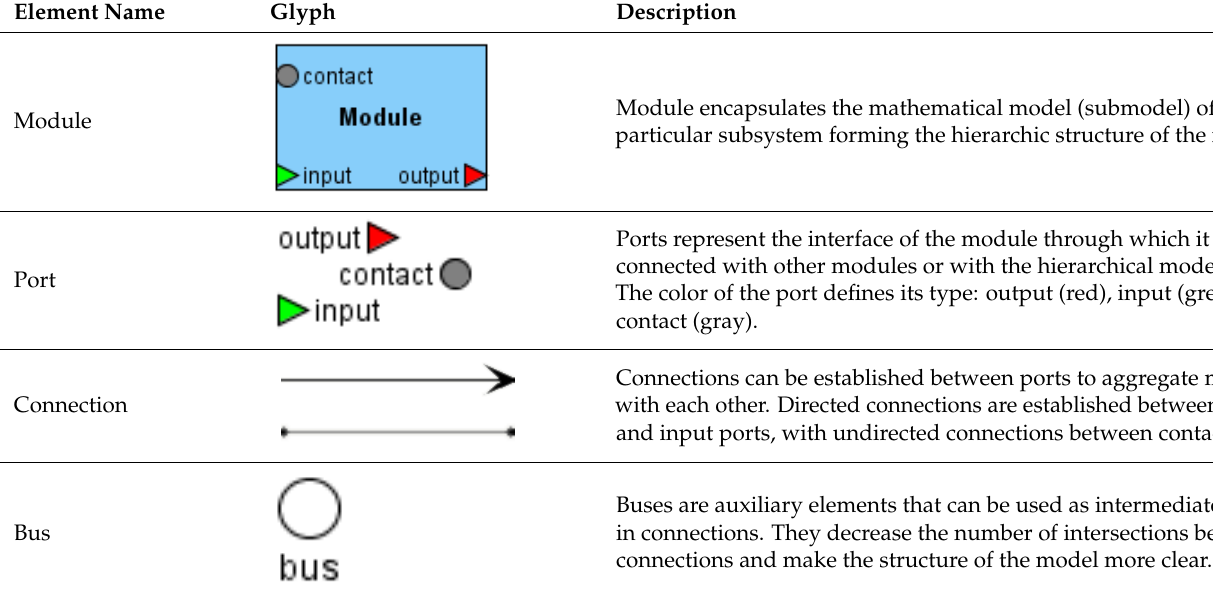
Table 2. Glyphs and arcs for modular diagrams.